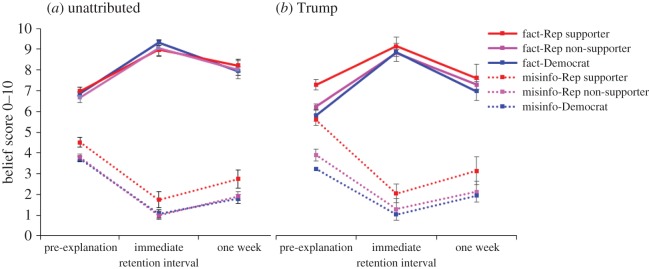
(a,b) Belief in Trump and unattributed misinformation and facts over time, across Trump support groups and source conditions. Rep, Republican; misinfo, misinformation. Dotted lines show misinformation items. Error bars denote 95% confidence intervals.